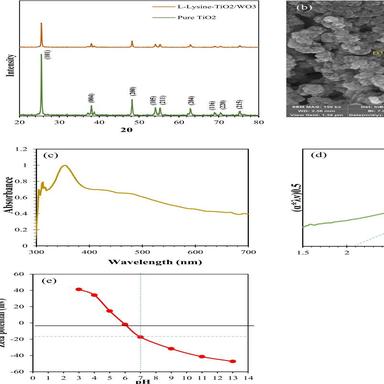
(a) XRD pattern, (b) FESEM image, (c) DRS spectrum, (d) Tauc plot and (e) zeta potential of L-Lysine (C, N codoped)-TiO2/WO3 photocatalyst.